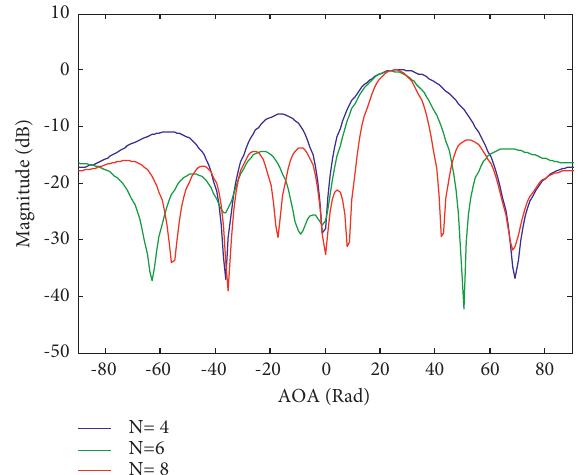
Figure 3: Effect of number of elements N on radiation (LMS).